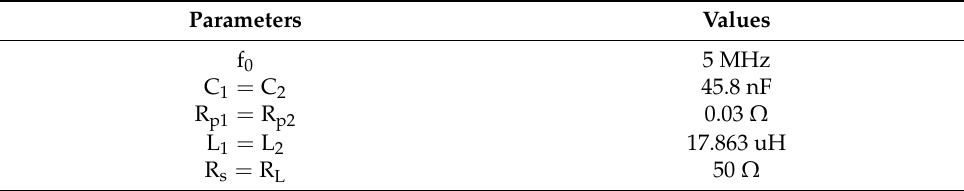
Table 2. Circuit component and parameter values of the two-coil system simulation